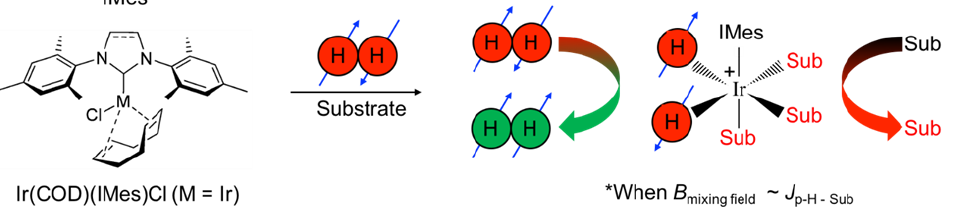
Figure 1. In the presence of p -H 2 and substrate, a pre-catalyst [e.g., Ir(1,5-cyclooctadeine)(1,3-bis(2,4,6-trimethylphenyl)imidazolium)Cl, Ir(COD)(IMes)Cl)] first undergoes a 4- to 6-coordinate transformation induced by the initial exposure to p -H 2 , giving rise to the standard “IrIMes” SABRE catalyst [17]. The formation of a transient hexa-coordinate center, wherein the symmetry of the nascent hydride spins is broken, allows spin order to be transferred to reversibly ligating substrates through the J-coupling network, particularly within a mixing field (B mixing field ) that roughly matches the frequency difference between source (parahydrogen-derived hydrides) and target spins (protons or other spin − 1/2 nuclei of the exchangeable substrate) to the magnitude of the J coupling.